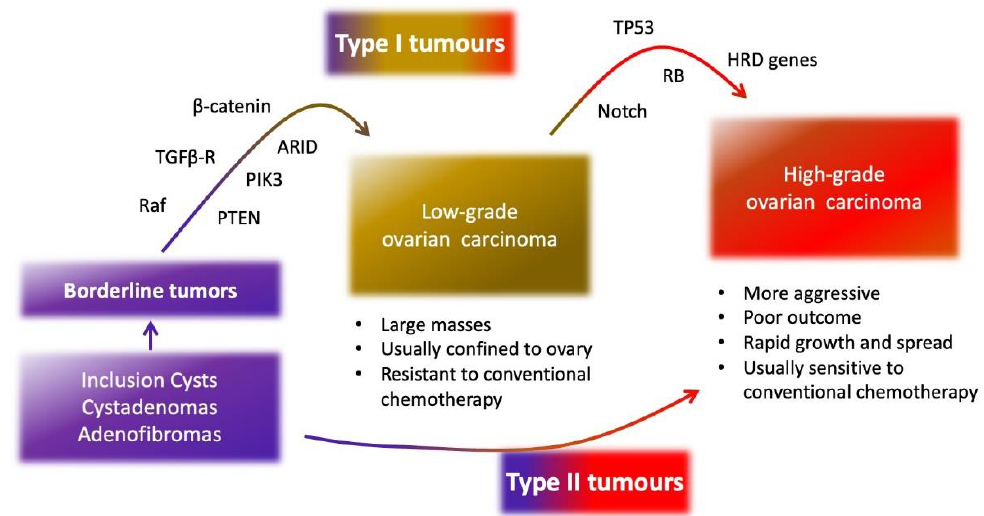
Figure 1. Main characteristics of type I and type II ovarian tumours. Type I tumours are characterized by sequential and low growth from the cyst and borderline tumours. In contrast, the evolution of type II tumours from pre-neoplastic lesions is quicker, resulting in an aggressive phenotype. Tumour evolution involves the acquisition of mutations in onco-suppressor genes as RAF kinase, beta- catenin, phosphatase and tensin homolog (PTEN), transforming growth factor-beta receptor (TGF- βR), phosphatidylinositol-4,5-bisphosphate 3-kinase (PIK3), AT-rich interactive domain-containing protein (ARID), TP53, retinoblastoma protein (RB), homologous recombinant deficiency (HRD) genes, and Notch pathway.